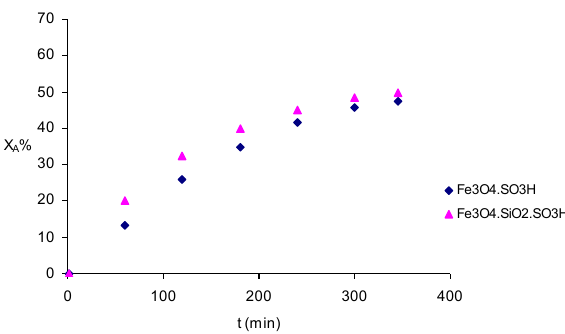
Fi gur e 5: Con v ers i on of palm iti c ac i d as a func ti on of ti me. Reac ti on cond iti ons: Palm iti c ac i d: me t hanol = 1:33 ( w/w ), 60 o C, 3 wt % ca t alys t